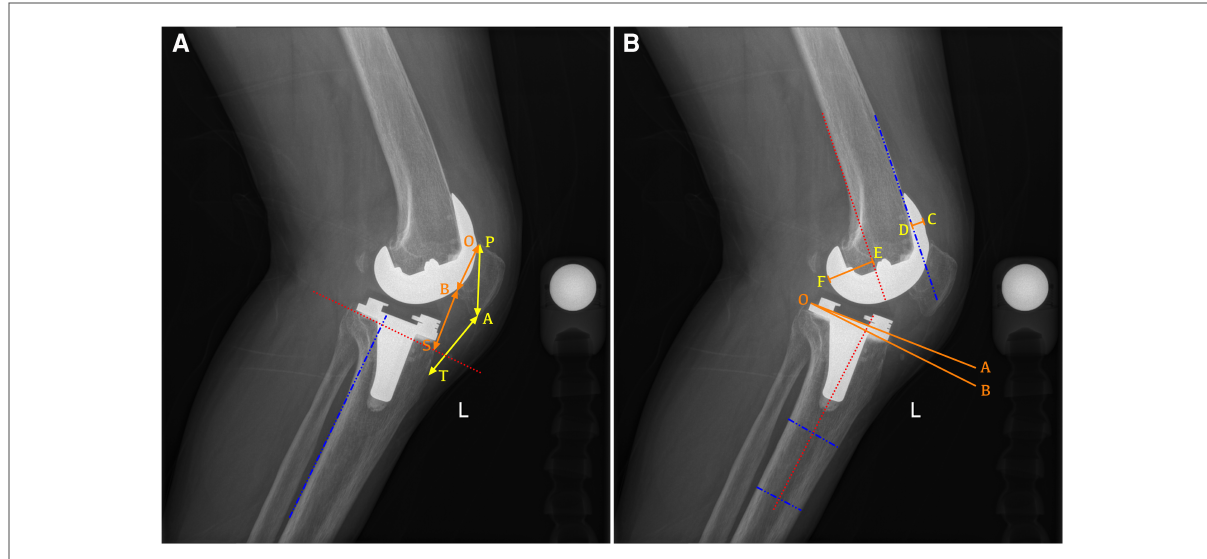
FIGURE 1 Radiographic measurement of the lateral view after PS-TKA. ( A ) Example of a radiograph demonstrating how to measure the Insall – Salvati ratio (AT/ AP) and modi fi ed Caton – Deschamps ratio (BS/BO). AT, length of the patellar tendon; AP, longest diagonal length of the patella; B0, length of the articular surface of the patella; BS, distance from the distal portion of the articular surface of the patella (B) to the intersection between the line perpendicular to the tibial posterior cortex elevated at the tip of the fi bular head and the tibial anterior cortex (S). ( B ) Example of a radiograph demonstrating how to measure the proximal anatomic axis posterior tibial slope (the angle between lines AO and BO), the anterior condylar offset (CD, the distance between the anterior femoral cortical margin and the anterior margin of the femoral condyles), and posterior condylar offset (EF, the distance between the posterior femoral cortical margin and the posterior margin of the femoral